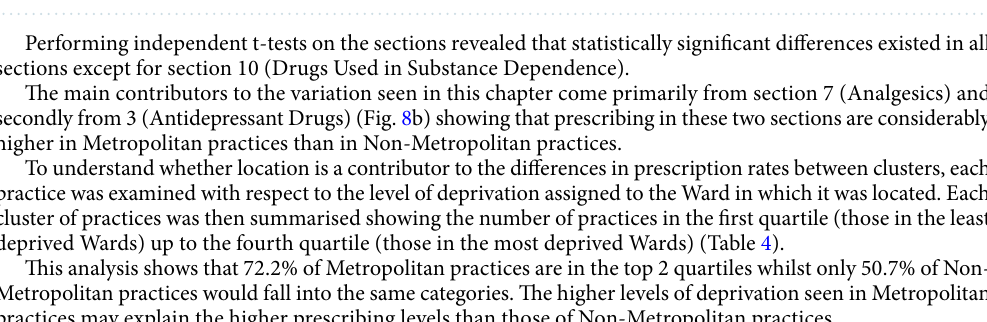
Figure 6. Number of items prescribed per registered patient by cluster over